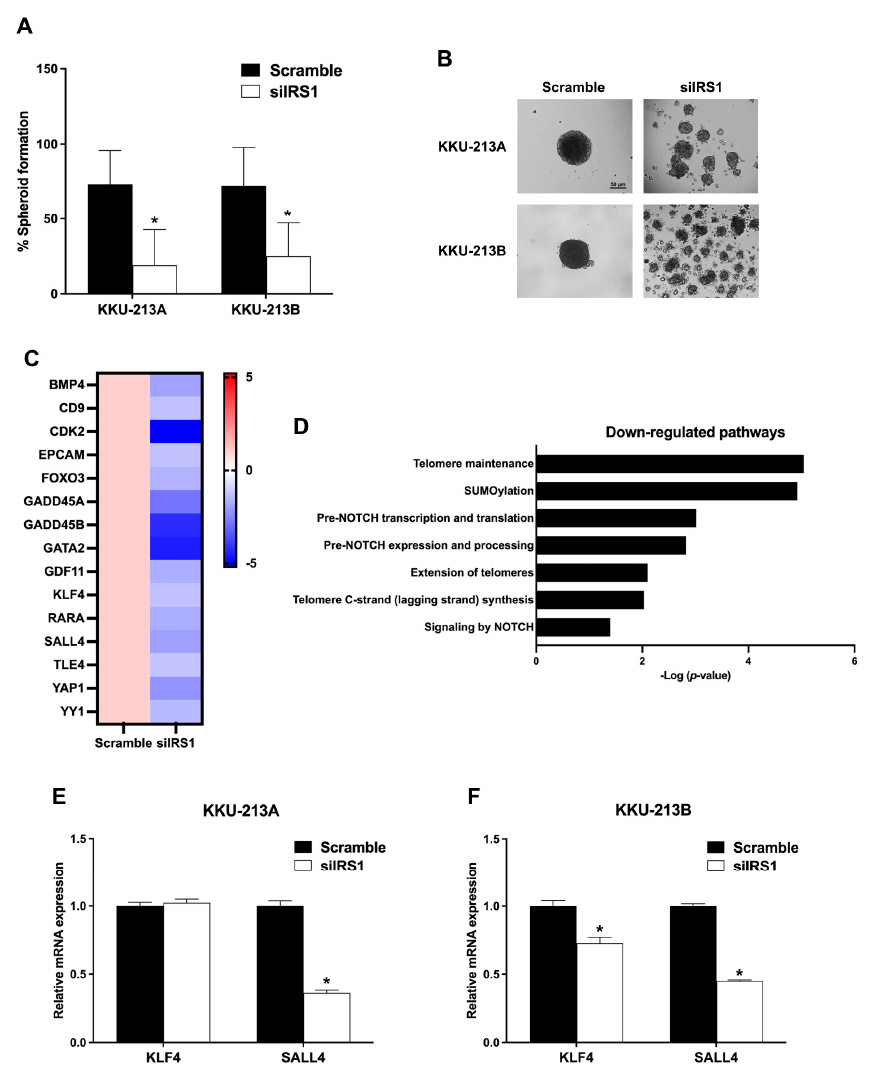
Figure 7. Effect of IRS1 on stem cell properties of CCA cell lines. ( A ) The percentage of spheroid- forming cells in KKU-213A and KKU-213B after IRS1 knockdown; at least 12 spheroids were analyzed in each condition. ( B ) Representative pictures of spheroid formation of KKU-213A and KKU-213B in bright-field microscopy (100 × magnification). ( C ) Heatmap represents fold changes of stem cell-related gene expressions in IRS1 knockdown KKU-213B cells investigated by RNA sequencing. ( D ) Reactome pathway demonstrated downregulation of stem cell-related pathways in IRS1 silencing KKU-213B cells. ( E , F ) The mRNA levels of stem cell markers (KLF4 and SALL4) in CCA cell lines after IRS1 suppression. * p -value < 0.05 compared to scramble.